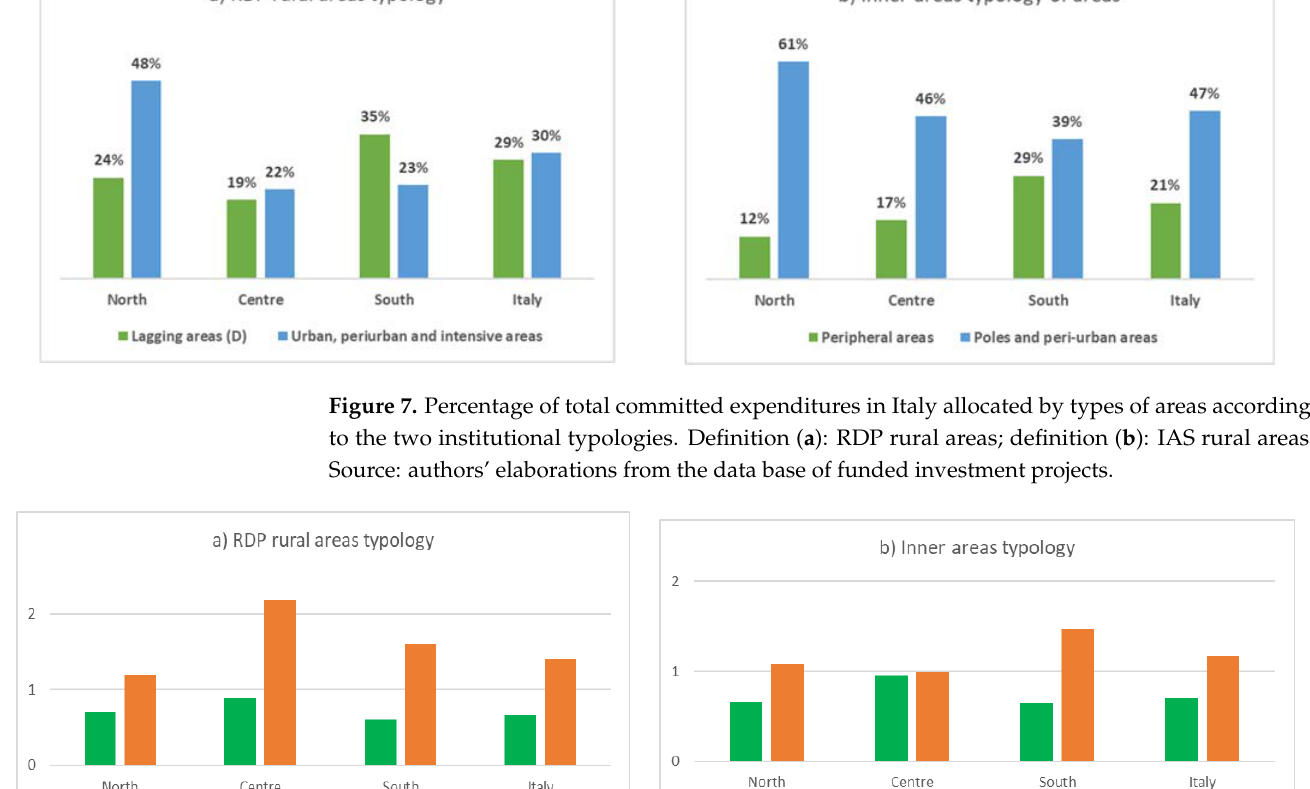
Figure 7. Percentage of total committed expenditures in Italy allocated by types of areas according to the two institutional typologies. Definition ( a ): RDP rural areas; definition ( b ): IAS rural areas. Source: authors’ elaborations from the data base of funded investment projects .